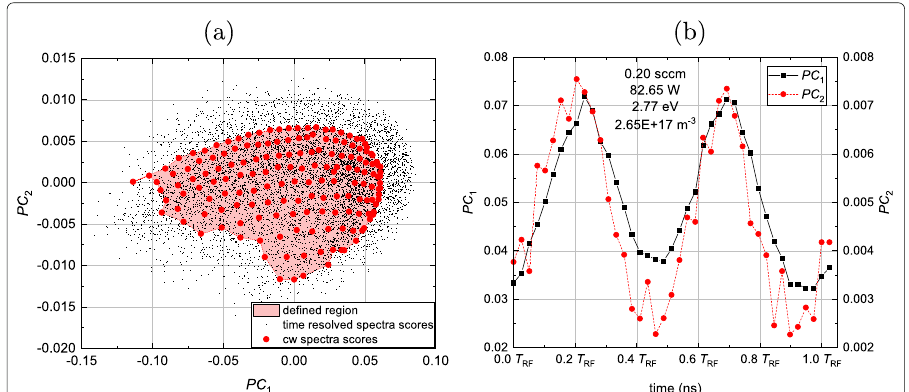
Fig. 8 PCA scores of the time-resolved optical emission measurements for a xenon plasma driven with 1.2MHz RF excitation ( a ). The defined region that is mapped by the scores of the cw optical emission spectra from which the correlation has been established is shown in red. Scores of time-resolved spectra outside this region cannot reliably be used to estimate plasma parameters as they lie outside the area where the one-to-one correlation was established and fitted. Plasma parameters extracted from the fitting in this range are uncertain. The oscillation of the PCA scores as a function of delay time is shown in ( b ) for a series of time-resolved spectra. Mass flow, RF input power and average electron temperature and density are given in the plot. PC 1 and PC 2 oscillate with twice the radio frequency as the corresponding line intensities in Fig.